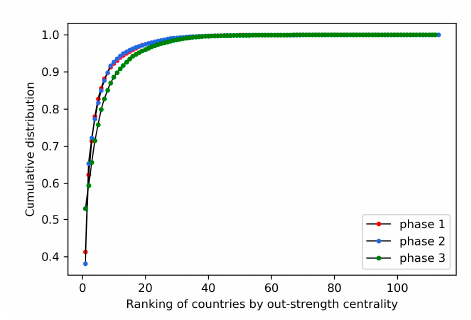
Figure 3. Cumulative distribution of out-strength centrality among BRI countries.